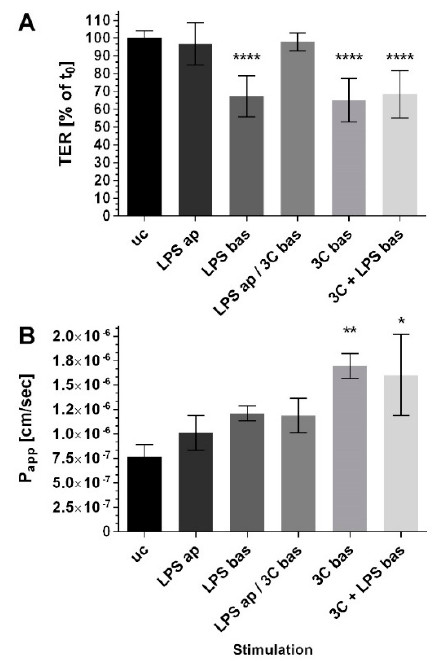
Figure 2. ( A ) Transepithelial electrical resistance measurements TER (% of t0), t0: time point prior to stimulation of each well, respectively; ( B ) transport assay using NaFlu, P app : the apparent permeability coe ffi cient (cm / s) of the coculture CC (Caco-2 / ISO-HAS-1) after stimulation with di ff erent pro-inflammatory mediators for 48 h. ap: apical, stimulation in the upper well (Caco-2), bas: basolateral, stimulation in the lower well (ISO-HAS-1); LPS: lipopolysaccharide (1 µ g / mL); 3C: cytokine mixture ((IL-1 β (100 U / mL), TNF- α (600 U / mL) and IFN- γ (200 U / mL)); data are depicted as means ± SE of three independent experiments with n = 3. For statistical analysis one-way ANOVA with Dunnett’s Multiple Comparison test was conducted. * p < 0.05, ** p < 0.01, and **** p < 0.0001.